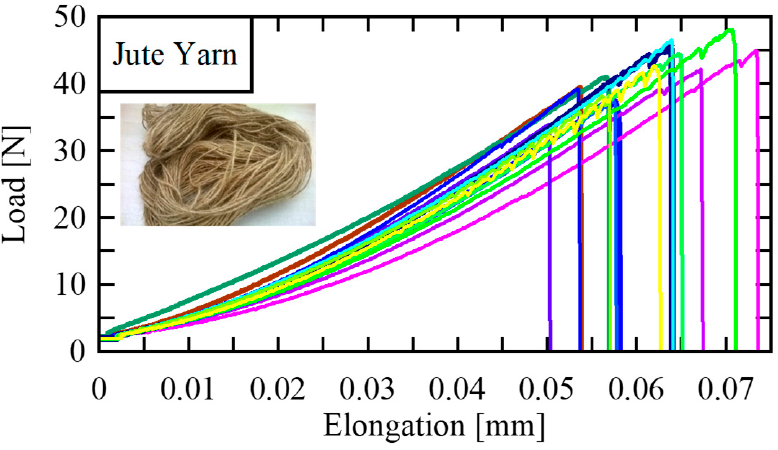
Figure 6. Typical load-elongation plots for jute yarn [2].